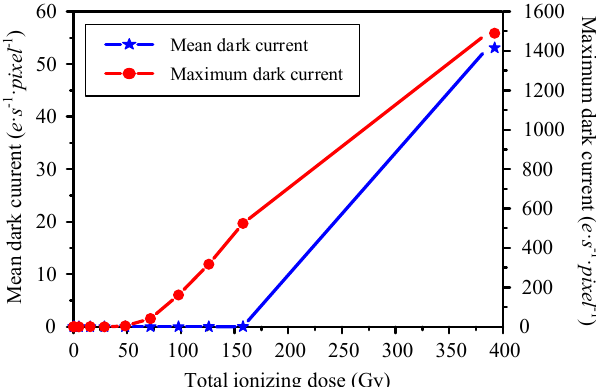
Figure 3. Histogram of mean and maximum dark current of images after different TID γ -ray irradiations.